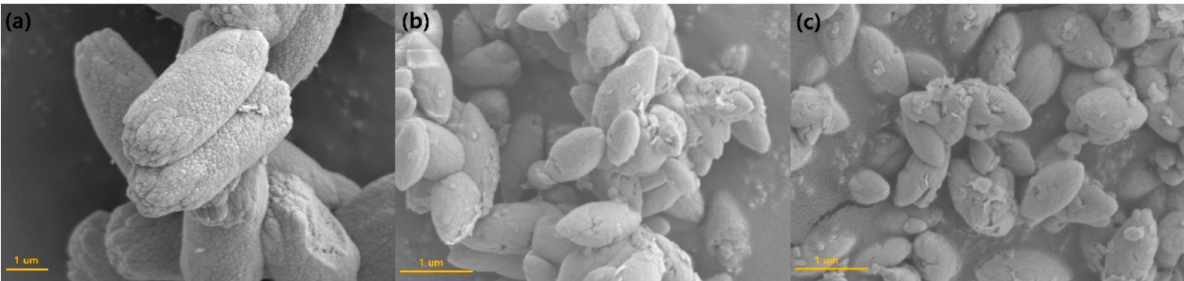
Figure 3. FE-SEM images of ( a ) CaMoO 4 , ( b ) CaMoO 4 :Tb 3+ , and ( c ) CaMoO 4 :Eu 3+